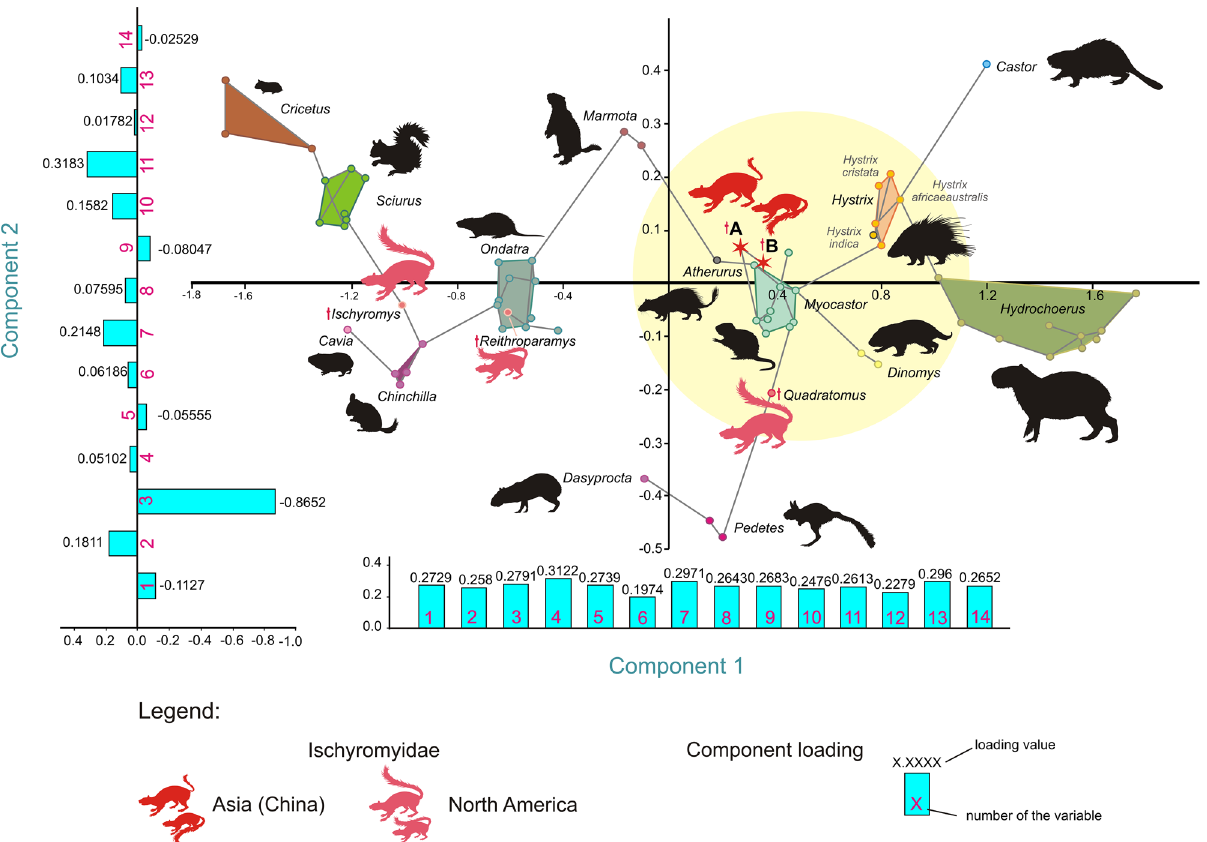
Figure 4. Principal component analysis of 14 metric parameters of rodent calcanei. The morphospace including paramyid calcanei from Nei Mongol in yellow circle. Lines connecting all data points represent a minimum spanning tree (MST) based on a Euclidean distance matrix. The loadings of the Components 1 and 2 shown at the corresponding axes. Strictly fossil taxa marked in red and pink, extant in black. (Figure created in Corel Draw X4 (v.14.0.0.567) by Łucja